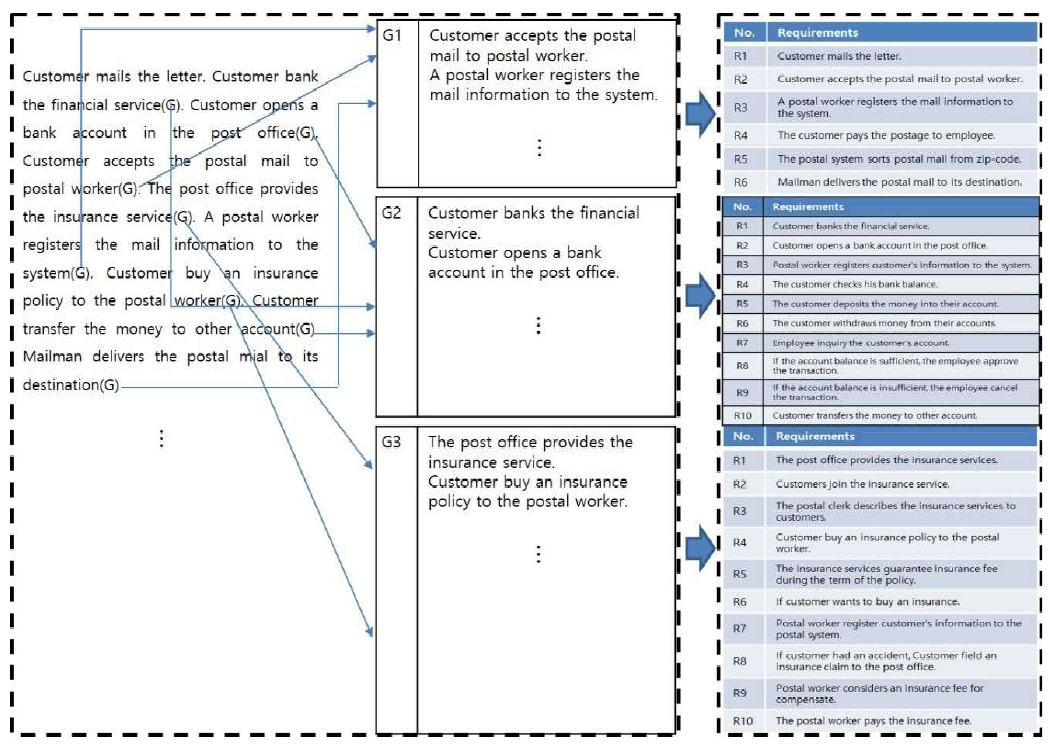
Figure 6. Goal identification and classification of natural language oriented informal requirement